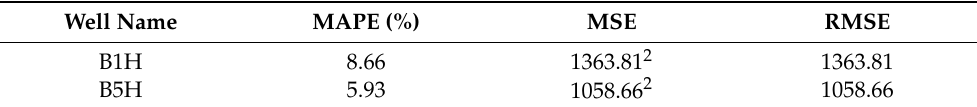
Figure 10. Comparison of the actual and predicted COP of the first cycle of the two horizontal wells: ( a ) well B1H; ( b ) well B5H. Table 5. Evaluation of the accuracy of the PA-LM model by the actual COP values of the two horizontal CSS wells.